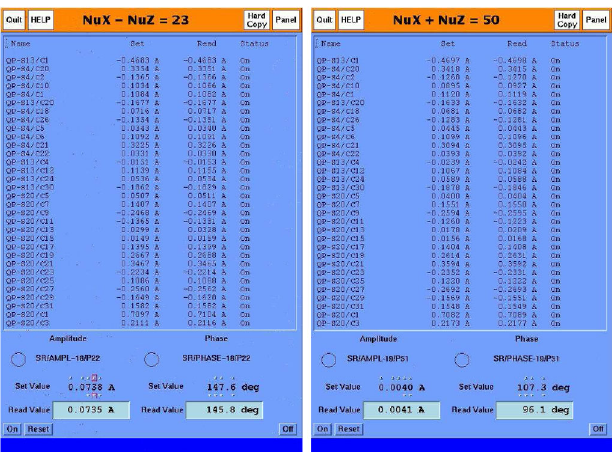
FIG. 9. Snapshot of the software application driving the trim values for the 32 skew quadrupole correctors. Amplitude A (already normalized in terms of magnet current) and phase (cid:4) for both resonances may be varied either by hand or by a coupling feedback software loop.